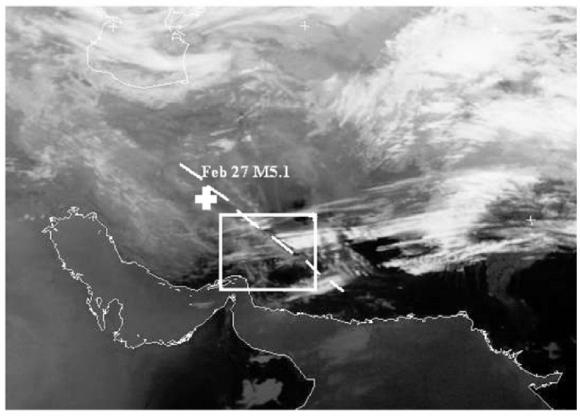
Fig. 2. Cloud image at 06:00 UTC on 20 February 2012. The dashed line is a major fault of Iran, and the square was our predicted future epicenter